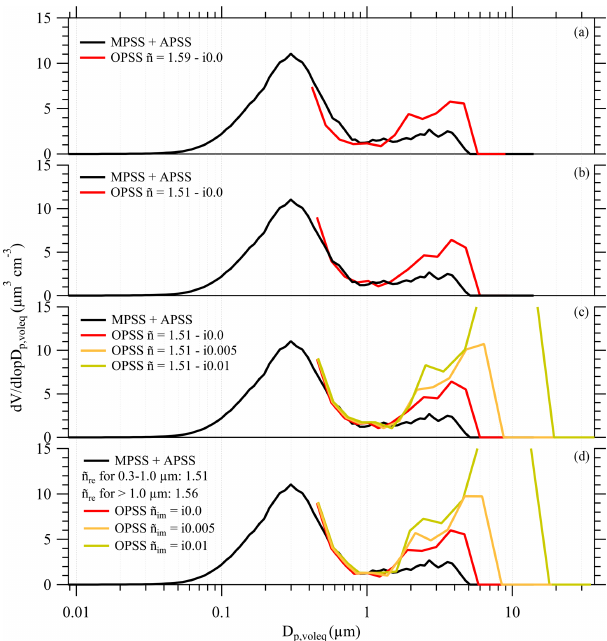
Figure 8. Demonstration of the complex refractive index correction done on the OPSS size distribution. In (a) , the x axis for the OPSS is the optical diameter ( D p , opt ). In the succeeding panels (b–d) , the OPSS PVSD has been corrected and the x axes are geometric mean volume equivalent diameters ( D p , voleq ).